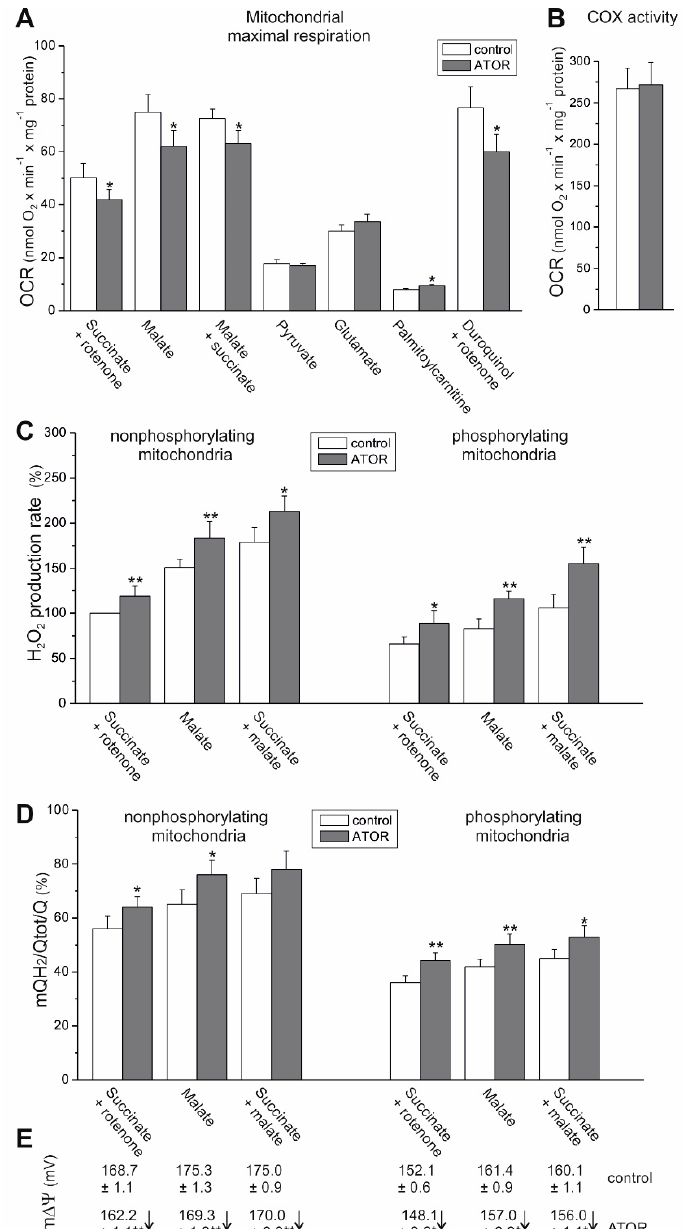
Figure 5. Functional characteristics of endothelial mitochondria isolated from control and ATOR-exposed cells. Maximal (phosphorylating or uncoupled) respiration with various respiratory substrates ( A ). Cytochrome c oxidase (COX, CIV) activity ( B ). Other functional parameters during succinate, malate, and a mixture of malate and succinate oxidation under nonphosphorylating conditions (in the absence of ADP) and under phosphorylating conditions (in the presence of ADP) ( C – E ). H 2 O 2 production with various substrates ( C ). Percentage relative to the control mitochondria oxidizing succinate alone (plus rotenone; 100%). mQ10 reduction level (mQH 2 /Qtot) ( D ). Mitochondrial membrane potential (m ∆Ψ ) ( E ). Mean ± SD; n = 4-8; p < 0.05 (*), p < 0.01 (**), comparison vs. control values.